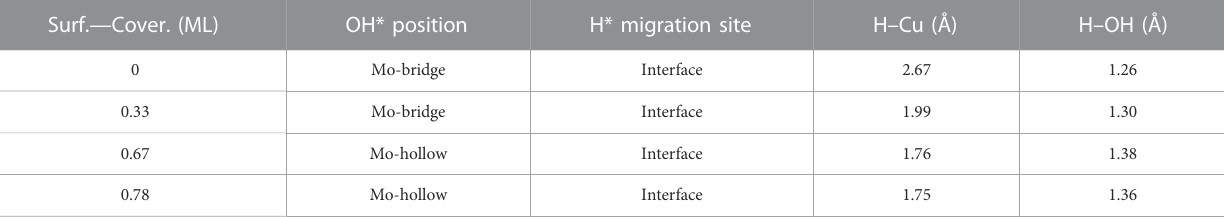
TABLE 4 Summary of OH* position, H* migration ’ s site, and H – Cu and H – OH bond lengths for the H* atom migration step from the Cu/Mo 2 C interface to OH* involved in the H 2 O* formation step (TS3) of the RWGS catalyzed by the Cu/Mo 2 C system in Å. Surf. — Cover. (ML)